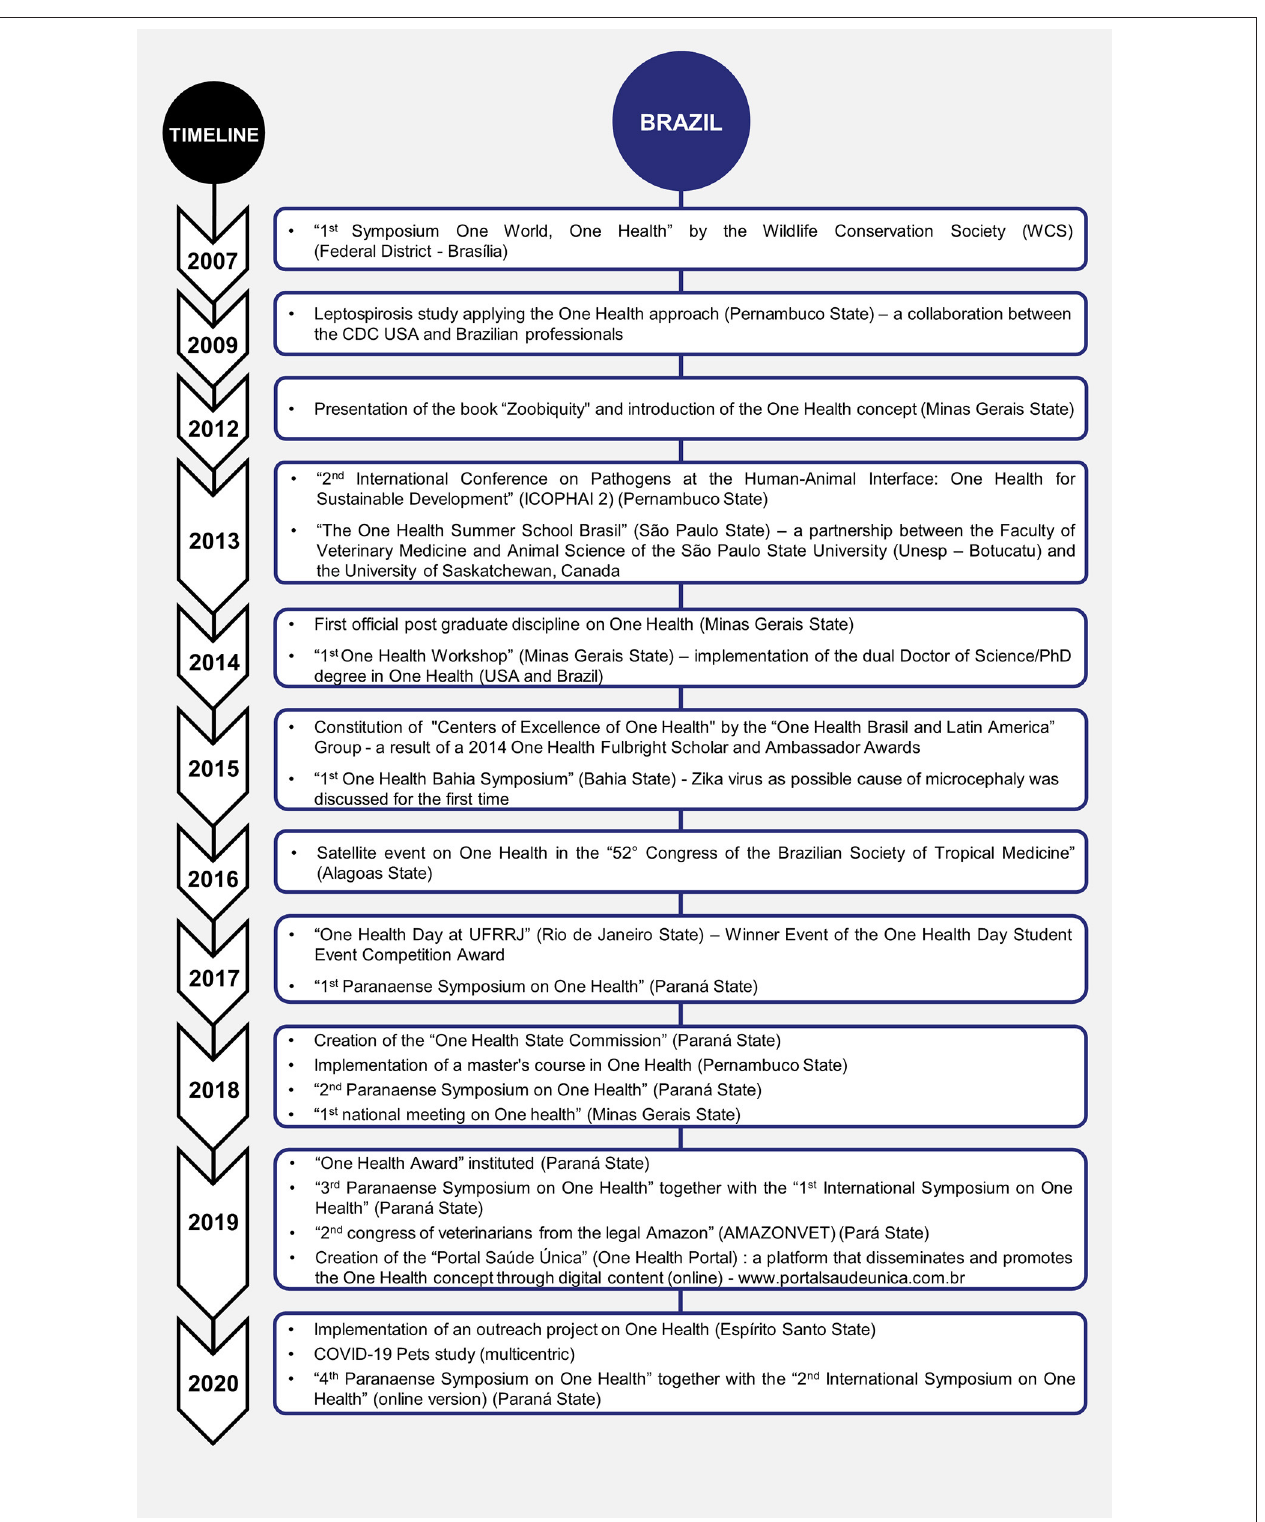
FIGURE 1 | One Health history and development in the last decades in Brazil.